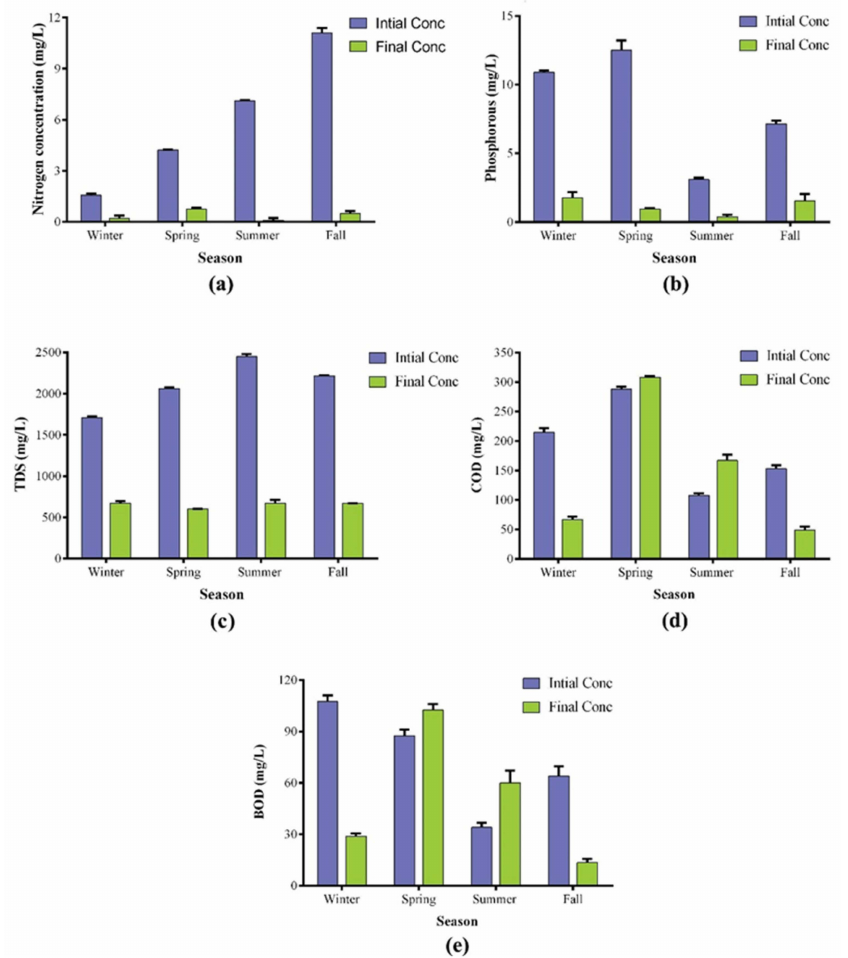
Figure 5. Post-cultivation water analyses of the water collected during different seasons: ( a ) total nitrogen (TN); ( b ) total phosphorous (TP); ( c ) total dissolved solids (TDS); ( d ) chemical oxygen demand (COD); ( e ) biological oxygen demand